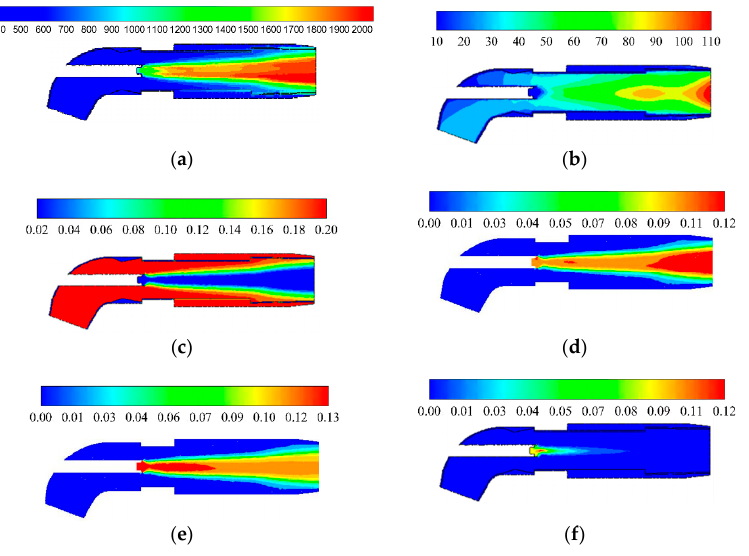
Figure 5. Temperature (K), Velocity field (m/s), O 2 , CO 2 , H 2 O (-), and light diesel oil mole fraction (-) of the burner before modification at the longitudinal cross section (XZ central cross section). ( a ) temperature (K), ( b ) velocity field (m/s), ( c ) O 2 concentration field (mole fraction), ( d ) CO 2 concen- tration field (mole fraction), ( e ) H 2 O concentration field (mole fraction), ( f ) light diesel oil concen- tration field (mole fraction).